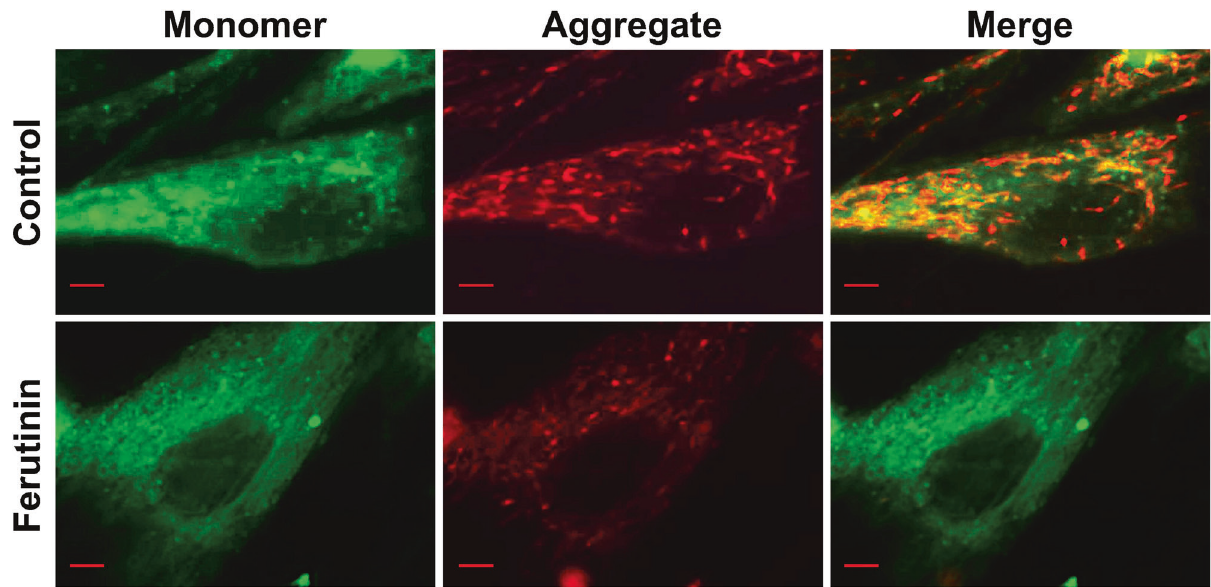
Fig. 4 Ferutinin reduces mitochondrial membrane potential in DPSCs. Ferutinin was added to the DPSCs and after 24 h cells were subjected to JC1 staining to detect mitochondrial membrane potentials. Images were captured for single cell. Controls were the vehicle-treated DPSCs. Scale bar = 10 μ M ( n =